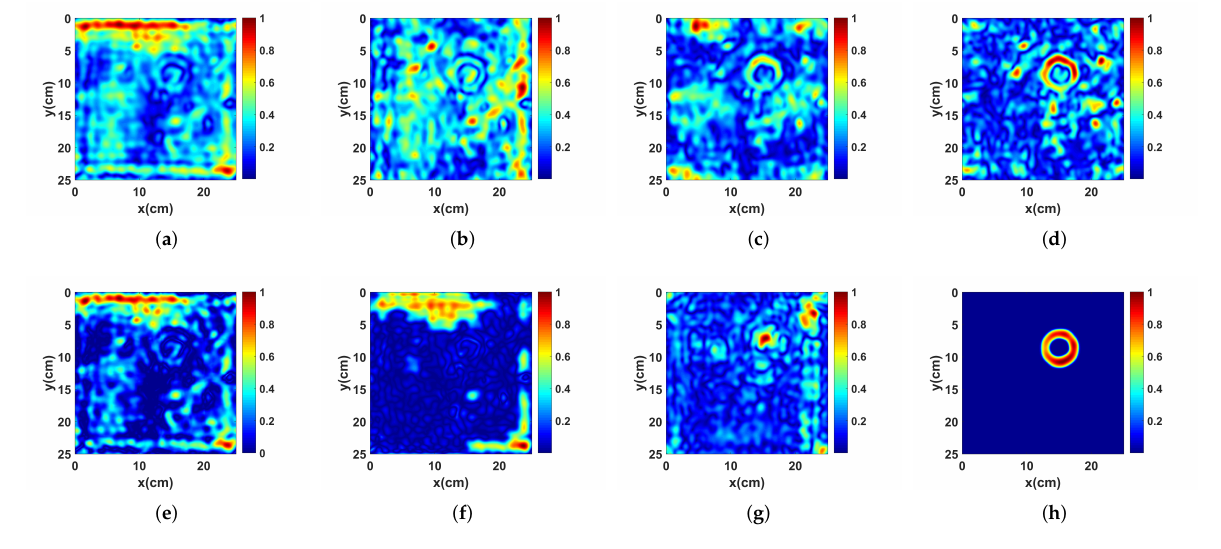
Figure 10. HSR images of Scene II before and after using different clutter mitigation methods. ( a ) No clutter mitigation. ( b ) Result of PCA. ( c ) Result of the standard SVD. ( d ) Result of the adaptive SVD. ( e ) Result of RPCA. ( f ) Result of MCA. ( g ) Result of the standard autoencoder. ( h ) Result of the proposed